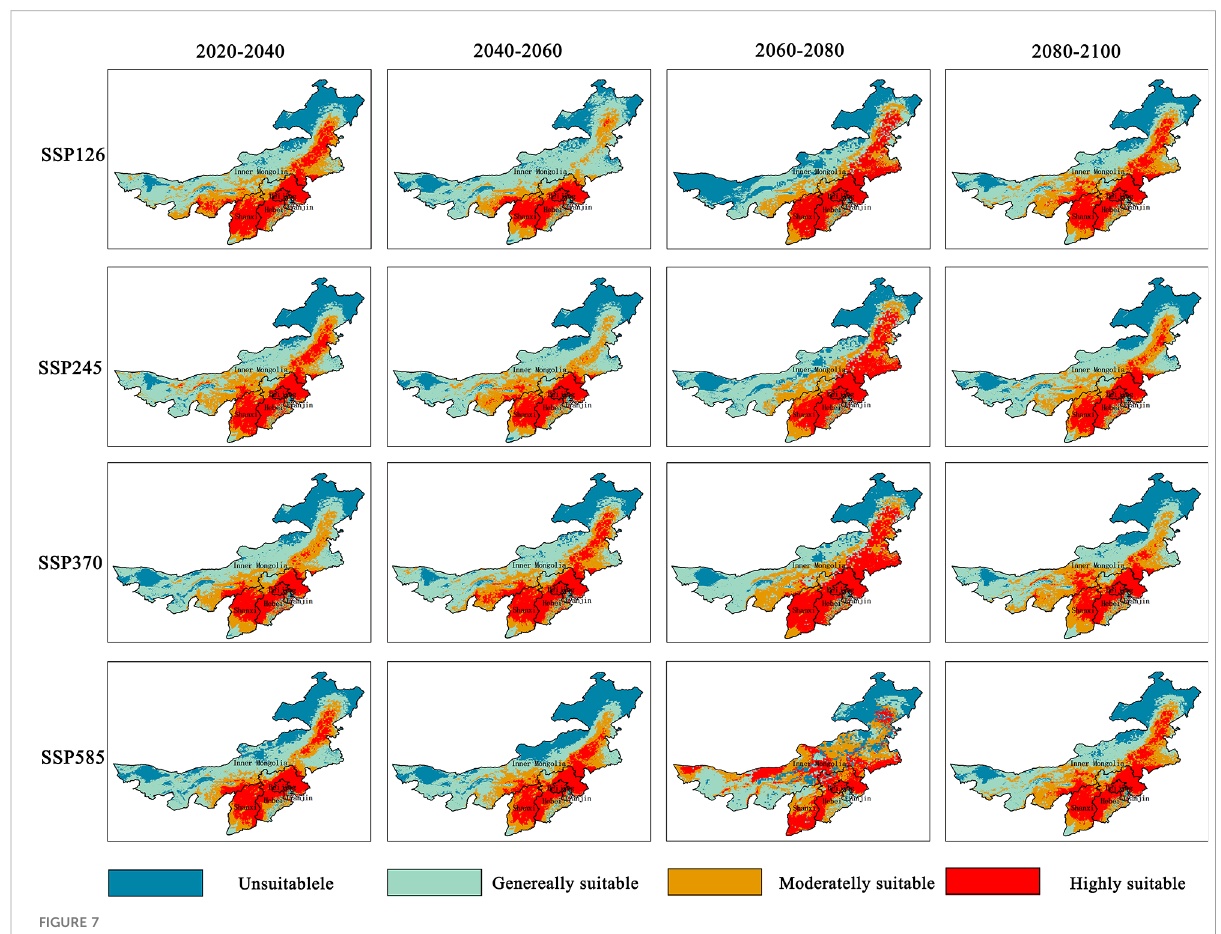
FIGURE 7 The potential distribution of naked oat under future